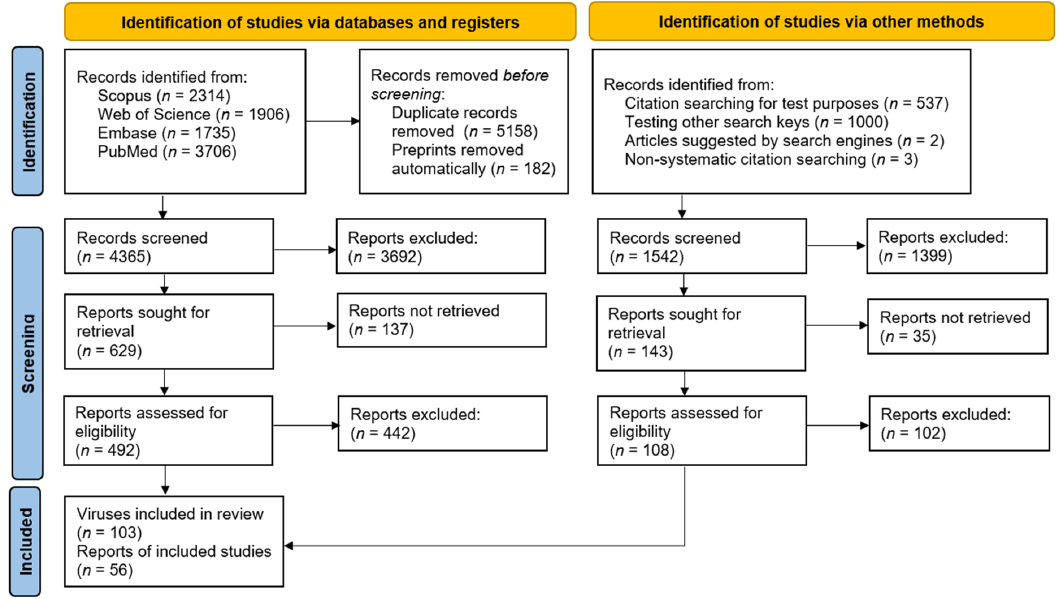
Figure 1. A simplified version of the Preferred Reporting Items for Systematic Reviews and Meta ‐ Analyses (PRISMA) flowchart [80] of studies screened and included in the review. Analyses (PRISMA) flowchart [80] of studies screened and included in the